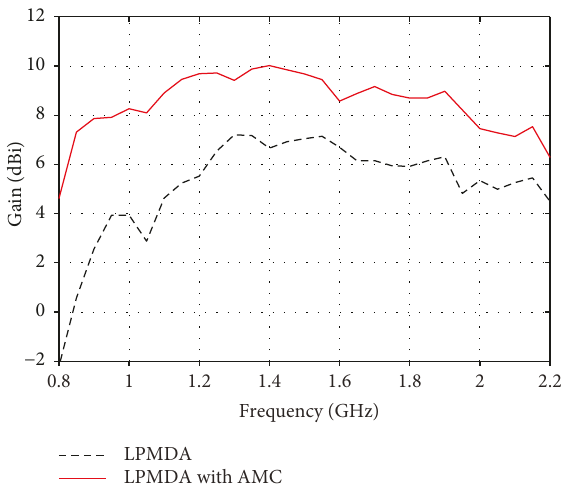
Figure 14: Measured gains of the proposed antennas in the main beam